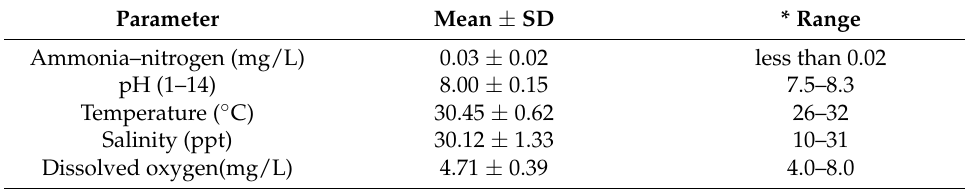
Table 3. The mean ± SD and range of water quality parameters in cage farm area during the study